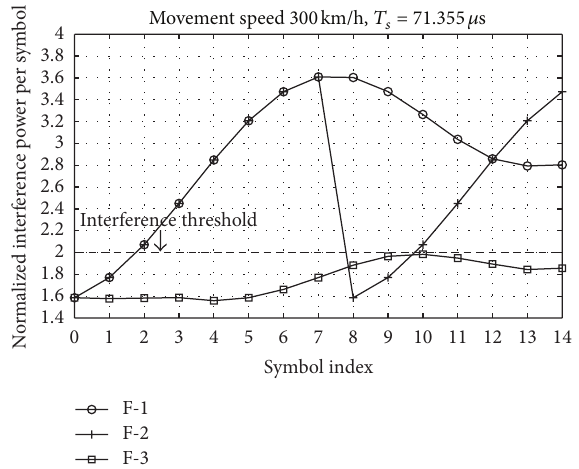
Figure 6: The interference power per symbol at primary receiver.